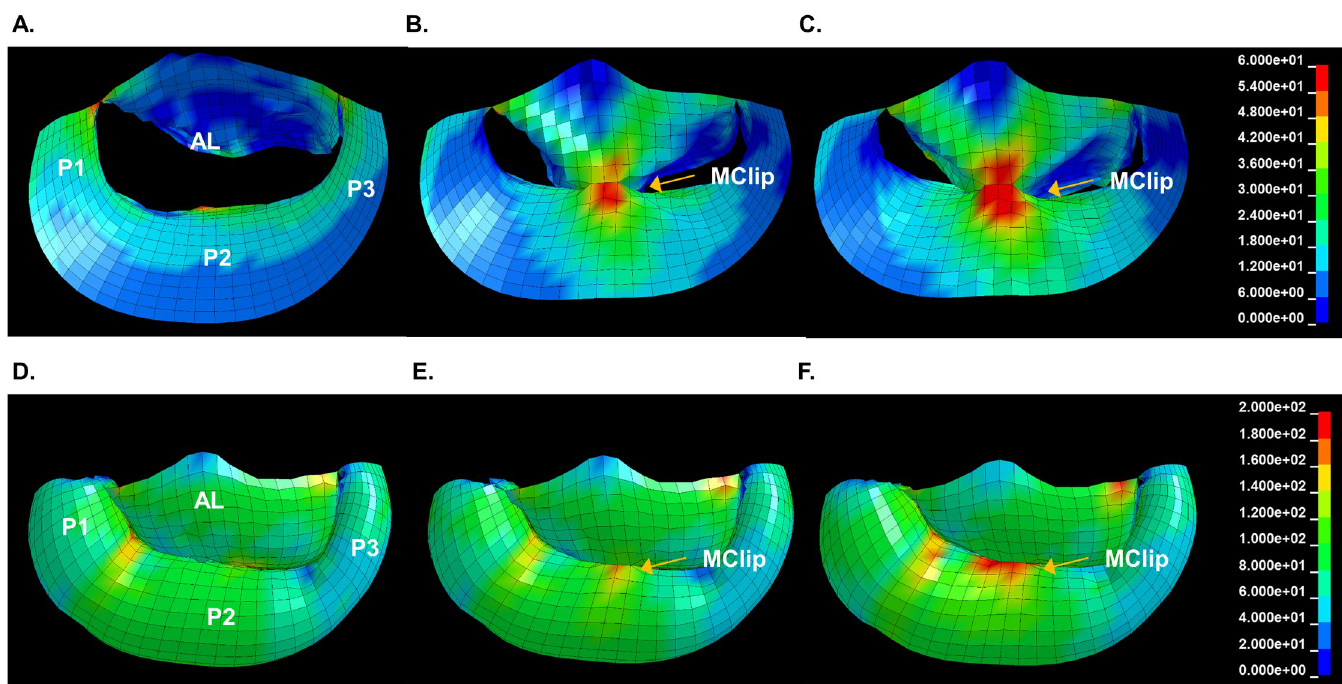
Fig 3. Representative Von Mises stress color maps of the mitral valve before (A and D) and after (B and E) virtual MitraClip and after MitraClip in an enlarged LV (C and F). Effects are seen at end- diastole (A—C) and end systole (D—F). Note that these color maps are not dimensionally exact. AL–anterior leaflet; P1,2,3 –posterior leaflet sections;